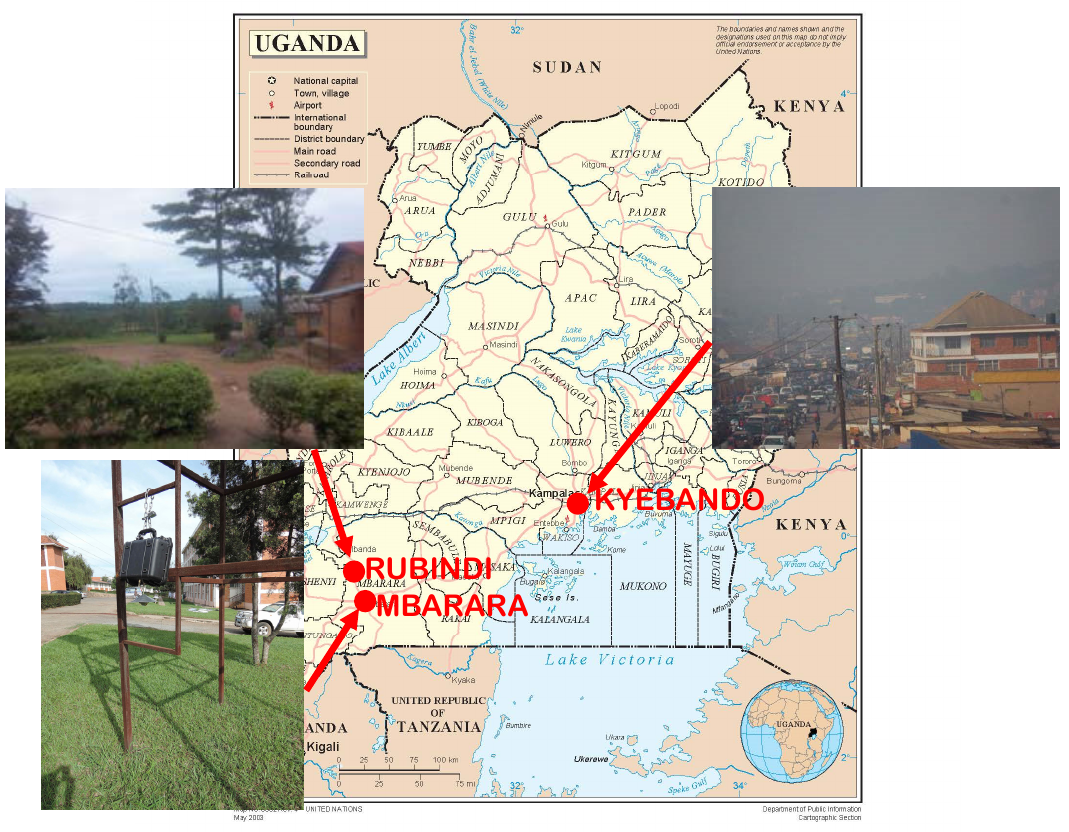
Figure 1. Data collection sites. The figure is based on the UN map of Uganda